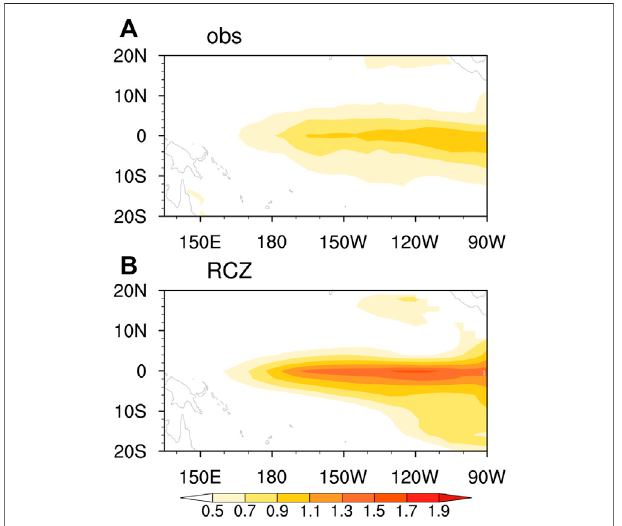
FIGURE13| Probabilitydensity function(PDF)forthecentroidlongitude of equatorial SSTA at the peak phase of (A) El Niño events and (B) La Nina events.ThePDFisestimatedbasedonbinnedhistogramsfromthe5000-year simulation. The width of the bins is one degree in